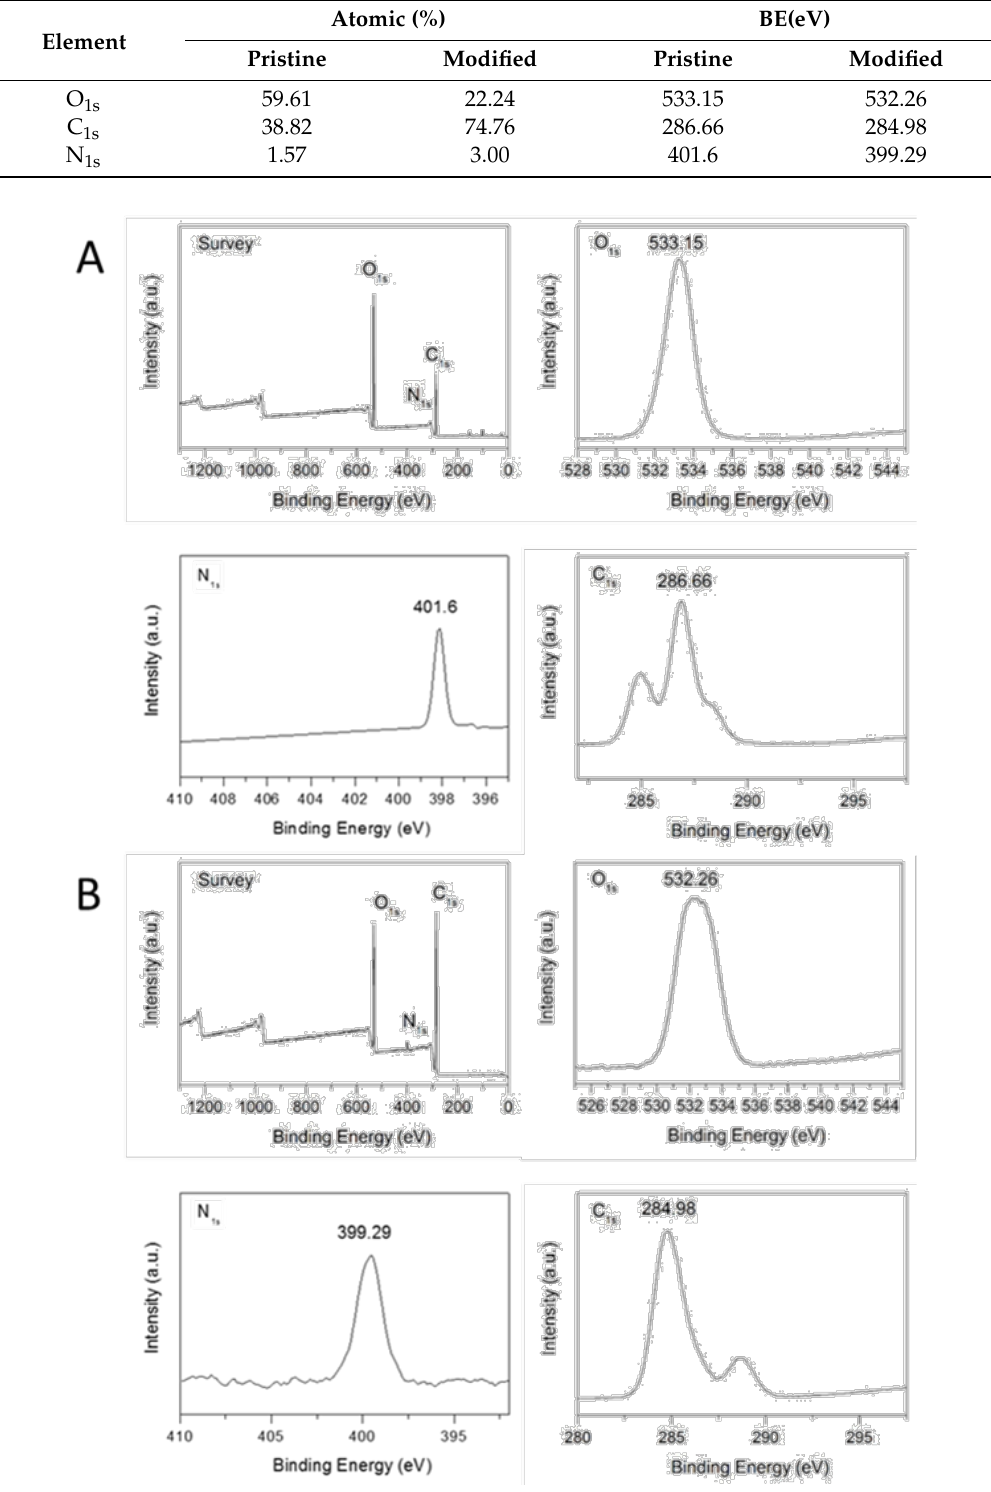
Figure 6. XPS results of ( A ) pristine and ( B ) modified cotton fabric .